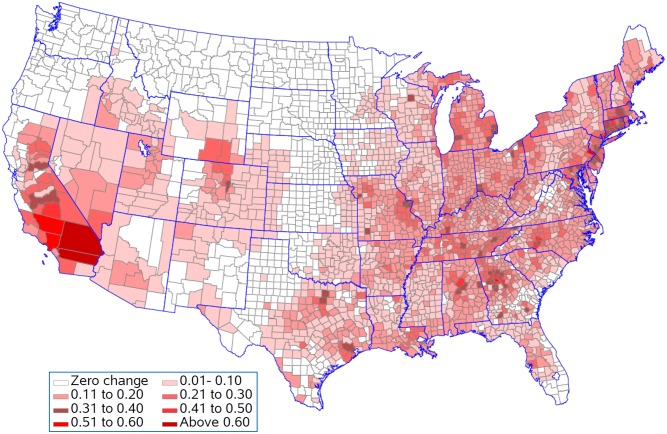
Reduction in life expectancy (years lost) resulting from being above the national 25th percentile for each pollutant.